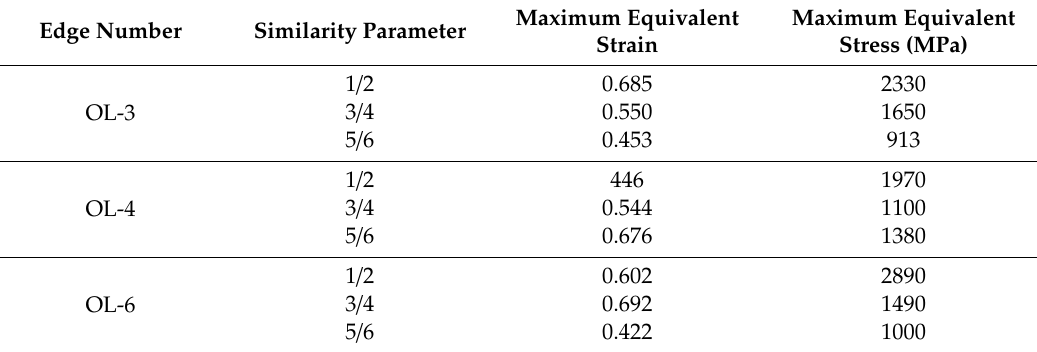
Figure 16. The compressive deformation of OL-4-3 / 4 panel. ( a ) The whole compressive deformation; ( b ) the z -directional compressive deformation. Table 5. Comparision of maximum mechanical strain and maximum equivalent stress.